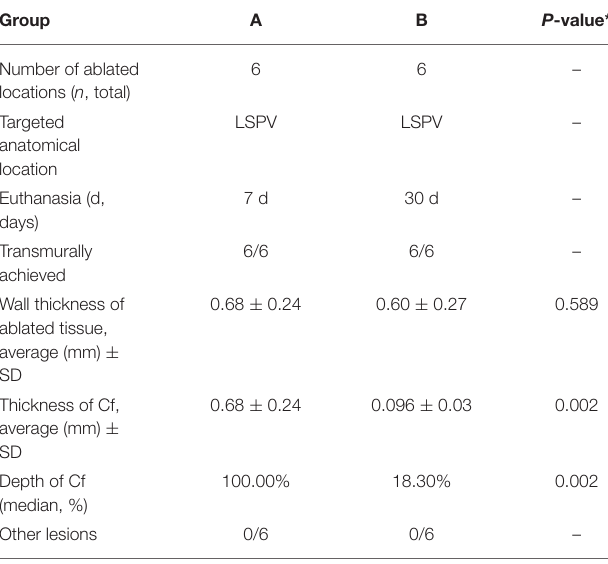
TABLE 3 | Comparisons for percentages of the collagen fiber depth over total thickness.